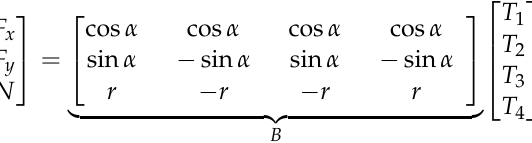
Figure 2. Horizontal thrust distribution diagram of UUV: ( a ) force direction of UUV three degrees of